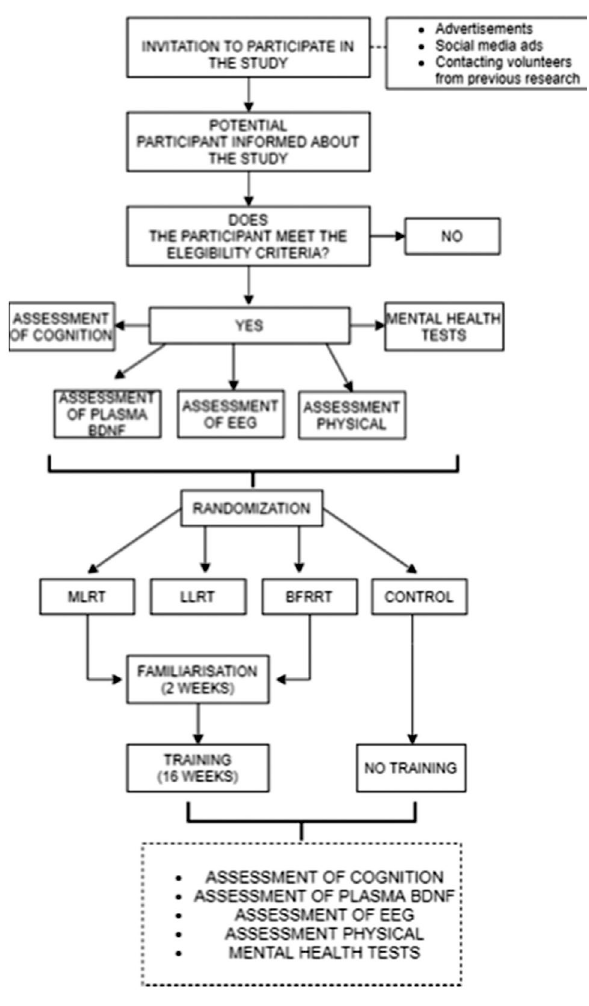
Figure 1 - Diagram of study